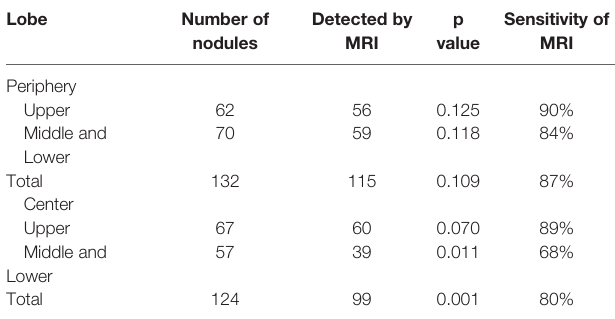
betweenthetwomethodsofCTandMRIinthegroupofupperlobeandmiddleandlower lobeofperipheralnodules.Inthecentralregion,thedetection rateoftheupperlobegroup was higher than that of the middle and lower lobe group, and the difference was statistically signi fi